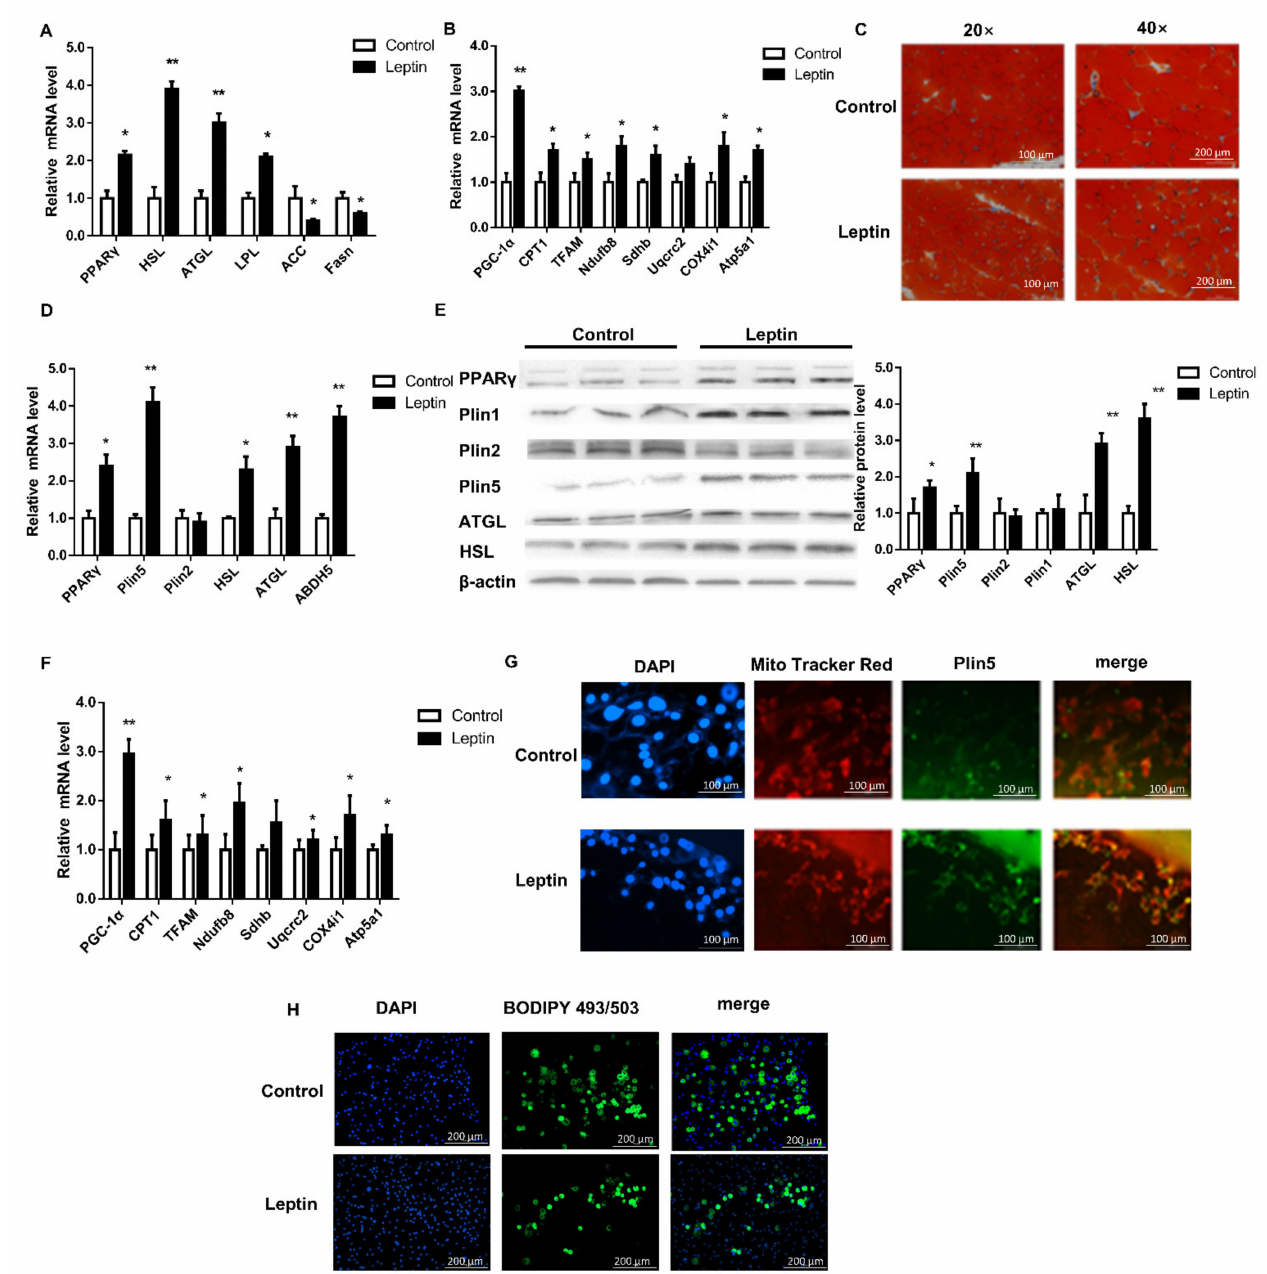
Figure 2. Leptin promotes lipolysis by up-regulating the expression of Plin5 in pig adipocytes. ( A , B ) Real-time quantitative PCR was used to detect the mRNA expression of Plin5, lipolytic genes and mitochondrial complex-related genes in piglets subcutaneous adipose tissue. n = 4 in each group. ( C ) Oil red O staining was used to observe the number and size of LD in the subcutaneous fat tissue of piglets. ( D ) Real-time quantitative PCR was used to detect Plin5 and lipolytic gene expression in porcine adipocytes in vitro treated with 50 nmol/ µ L leptin for 24 h. The effect of 50 nmol/ µ L leptin treatment of porcine adipocytes in vitro on: ( E ) the expression of Plin5 and lipolytic protein and ( F ) the mRNA expression of mitochondrial complex-related genes. ( G , H ) Porcine adipocytes in vitro were treated with 50 nmol/ µ L leptin for 24 h to detect Plin5 immunofluorescence or BODIPY staining analysis. n = 3 for each group of cell samples, values are means ± SD. vs. control group, * p < 0.05, ** p <